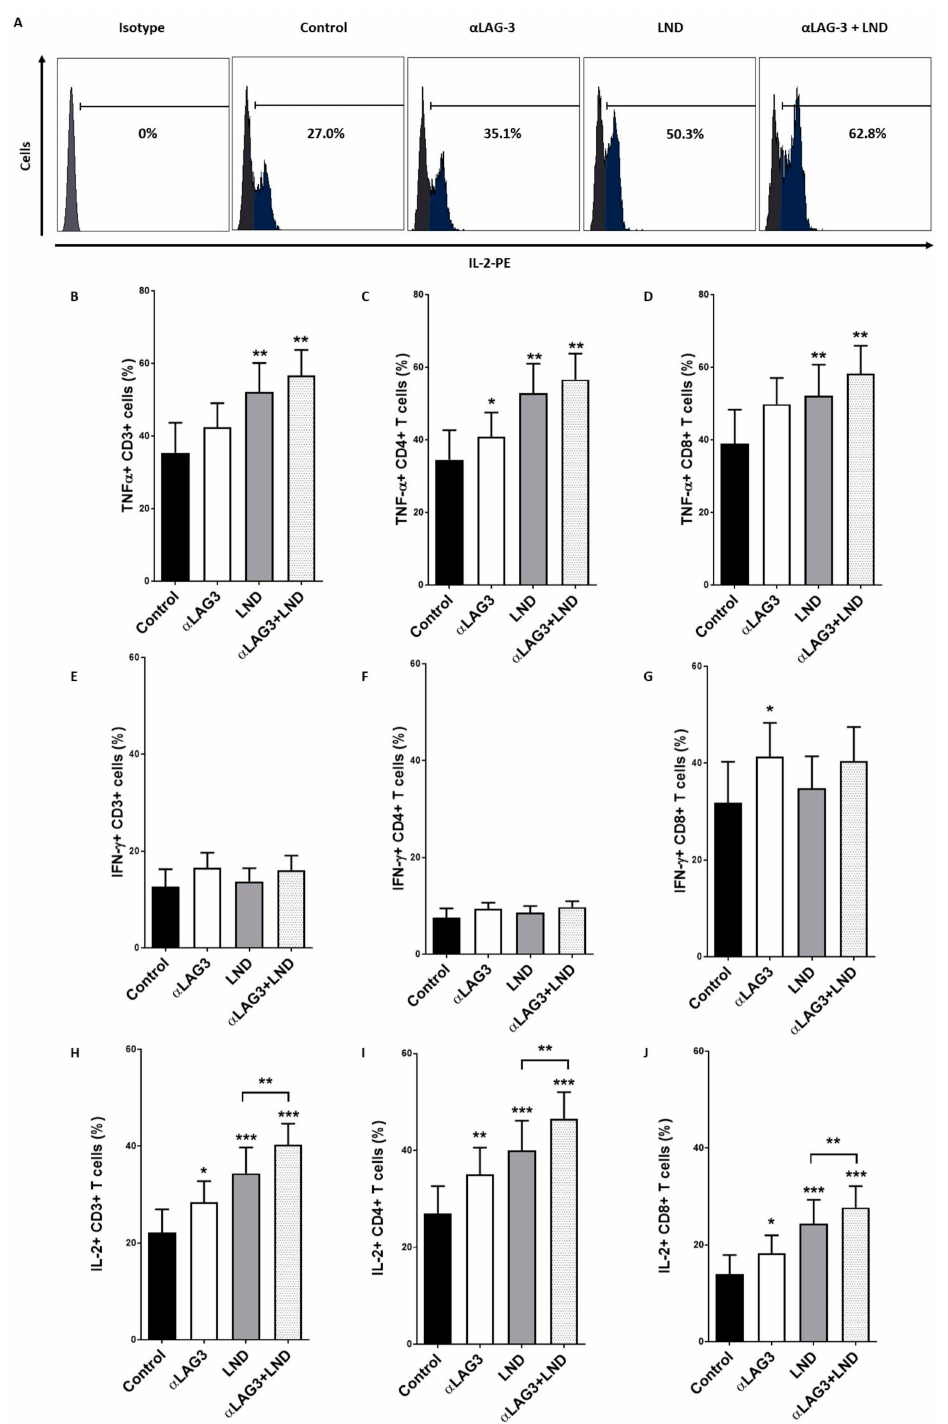
Figure 6. Relatlimab enhances cytokine production by T lymphocytes. ( A ) Representative histogram showing the effect of LAG-3 blockade, alone or in combination with lenalidomide, on IL-2 production by CD4+ T cells. ( B – J ) PBMCs from 11 patients with CLL were treated with relatlimab or isotype control (10 µ g/mL), alone or in combination with lenalidomide (LND, 10 µ M), for 72 h. The percentage of T cells expressing TNF- α ( B – D ), IFN- γ ( E – G ) and IL-2 ( H – J ) was evaluated by flow cytometry. * p < 0.05, ** p < 0.01 and *** p <